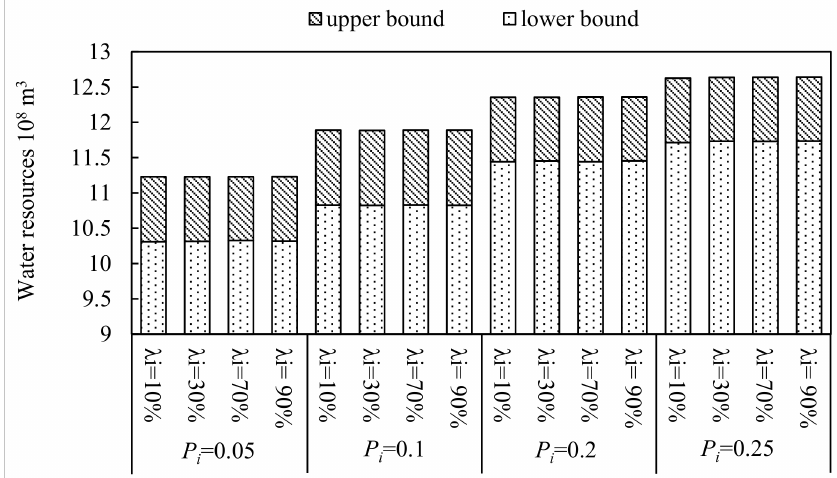
Figure 8. Irrigation water resources of di ff erent water-saving modes under di ff erent violation probabilities, P